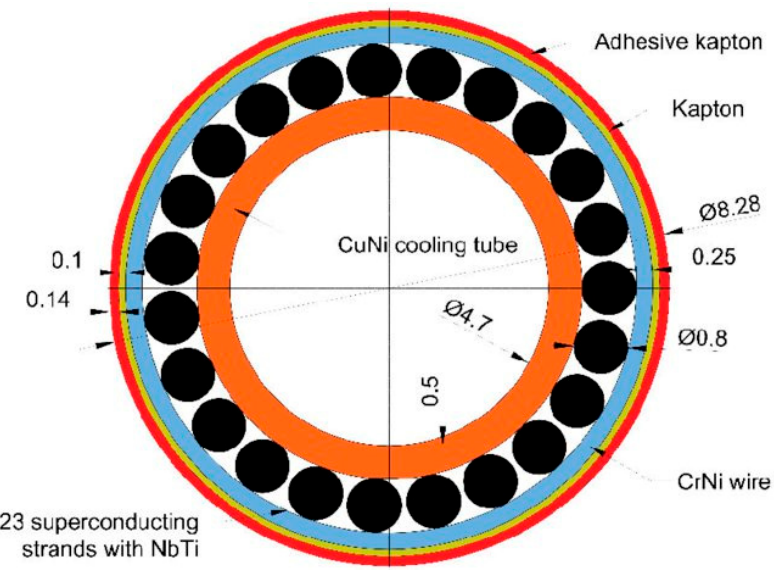
Figure 3. Cross section of the NbTi superconducting cable for the busbars of the SIS100 synchrotron [10].